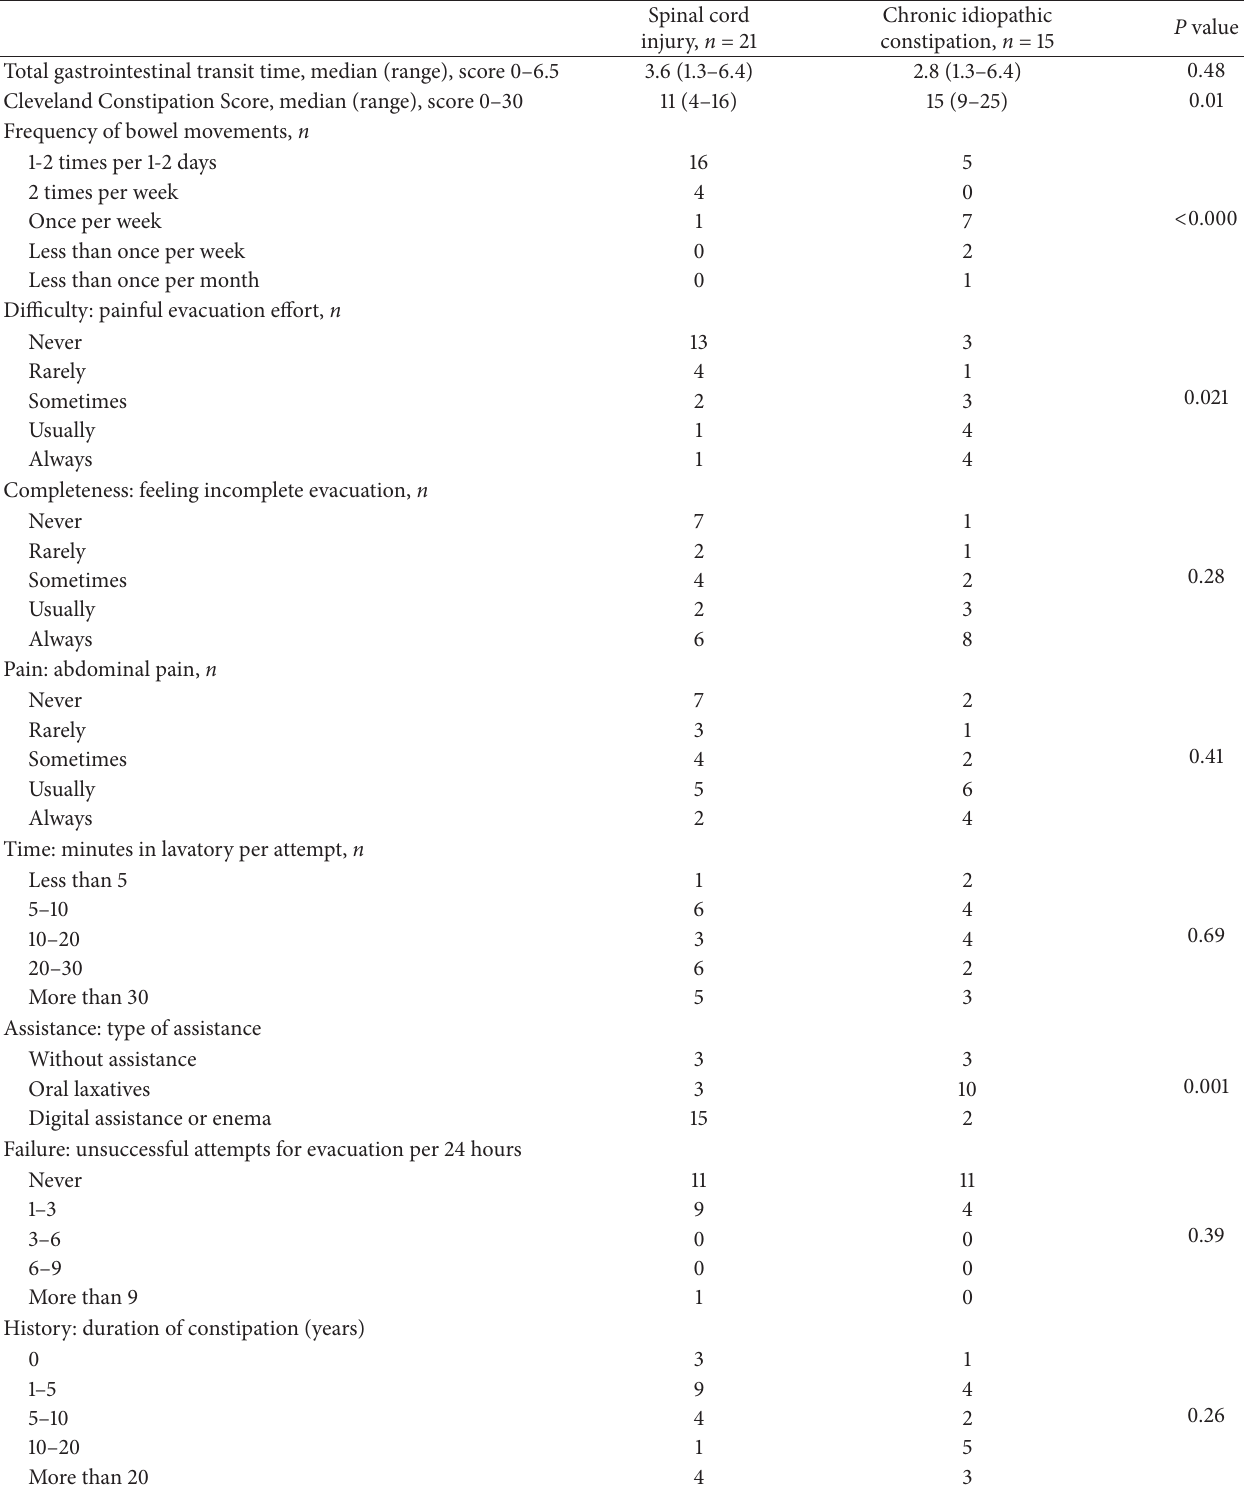
Spinal cord Chronic idiopathic P value injury, n = 21 constipation, n = 15